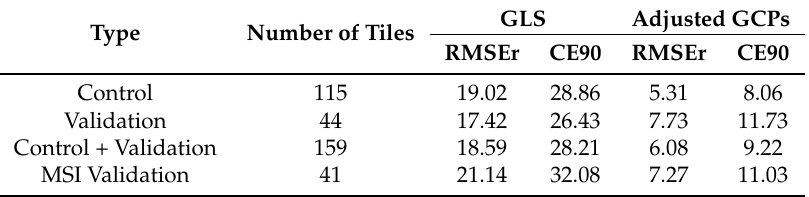
Table 14. Validation results for the Islands block using Image-to-Image characterization between the Sentinel-2 GRI tiles and Landsat 8 L1T products that were processed before (GLS) and after (Adjusted GCPs) bundle